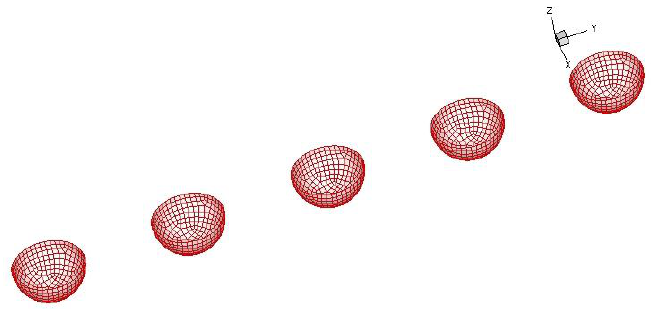
Figure 2. 3D mesh of the calculation model for the five hemispherical WEC devices in the validation test.